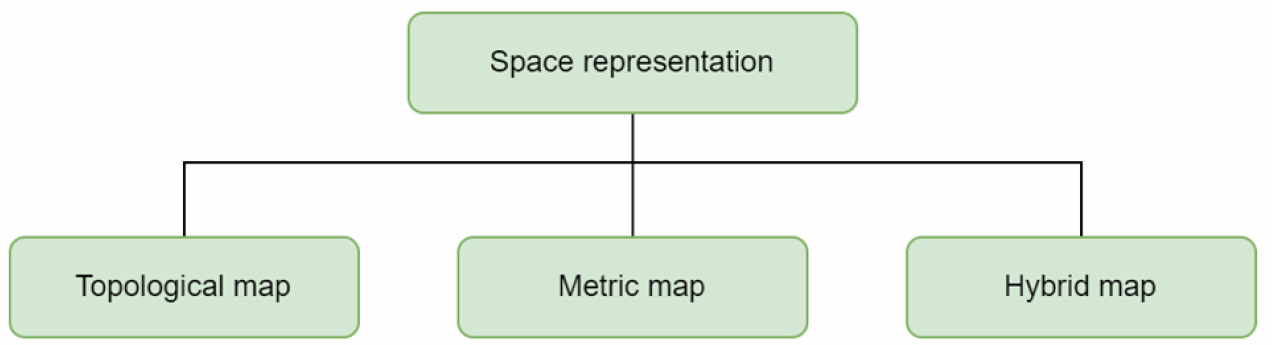
Figure 4. Representation of